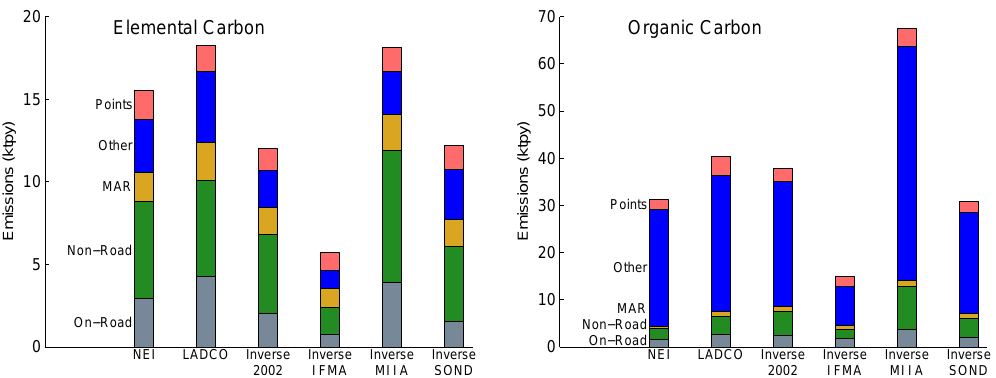
Figure 17. Emissions of EC and OC in the Regional domain by source type for the 2008 NEI, the 2007 LADCO inventory and the posterior estimate based on using LADCO as a prior. Inverse results are shown for the entire year (2002), along with annualized emissions for January–April (JFMA), May–August (MJJA) and September–December (SOND).